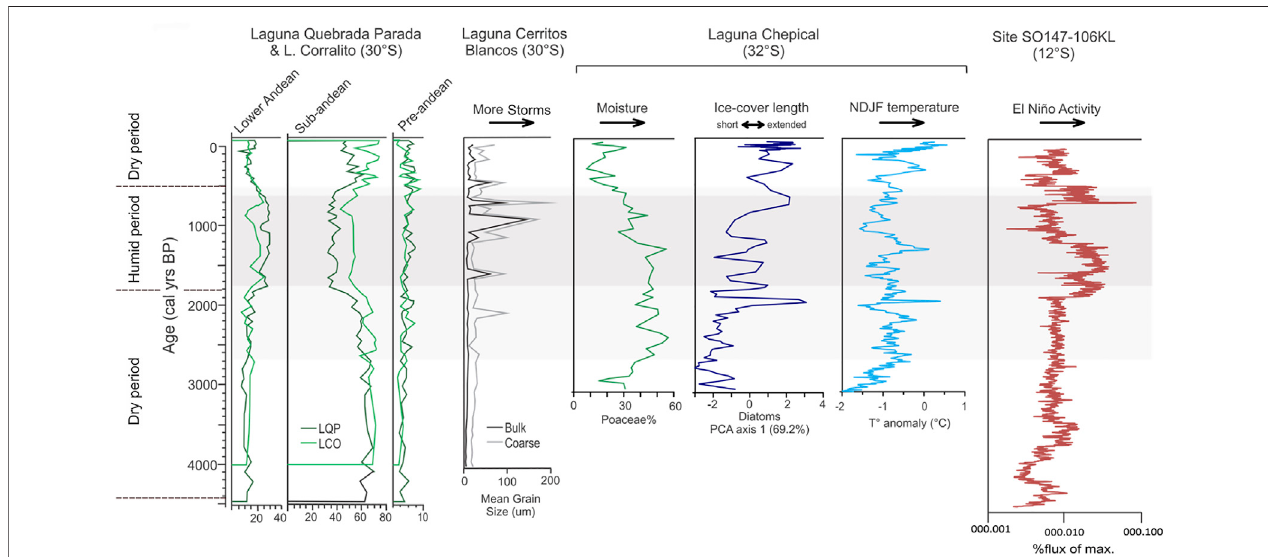
FIGURE 8 | Comparison of the pollen record summary from Laguna Corralito and Laguna Quebrada Parada, with Laguna Cerritos Blancos (Tiner et al., 2018), Poaceaepollen % (Martel-Cea et al.,2016), diatom record axis 1 PCA scores (Martel-Cea et al., 2016),NDJF temperature anomalies (de Jonget al., 2013) from Laguna Chepical and lithic content in the marine record, site SO 147-106KL, and offshore Peru (Rein et al., 2005). Wetter periods are highlighted in gray.